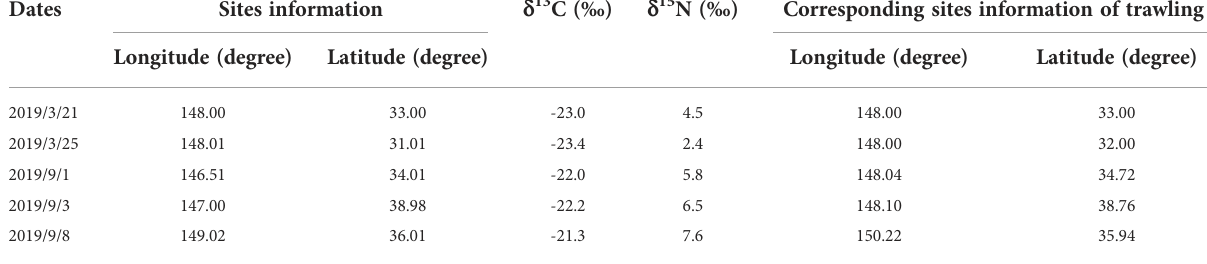
TABLE 4 Copepod information corresponding to the trawling sites.